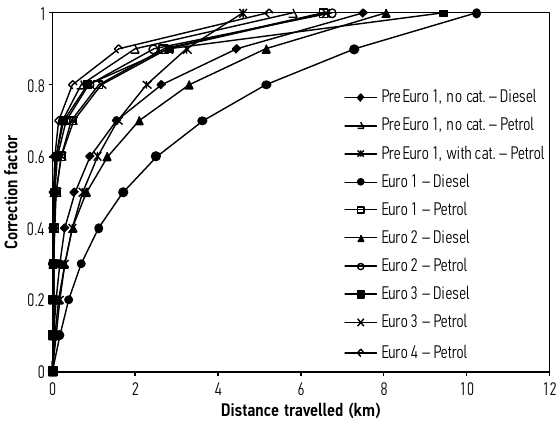
Distance travelled (km) Fig. 3. Schematic representation of the effect of trip length on the cold start excess emissions from passenger cars in winter season